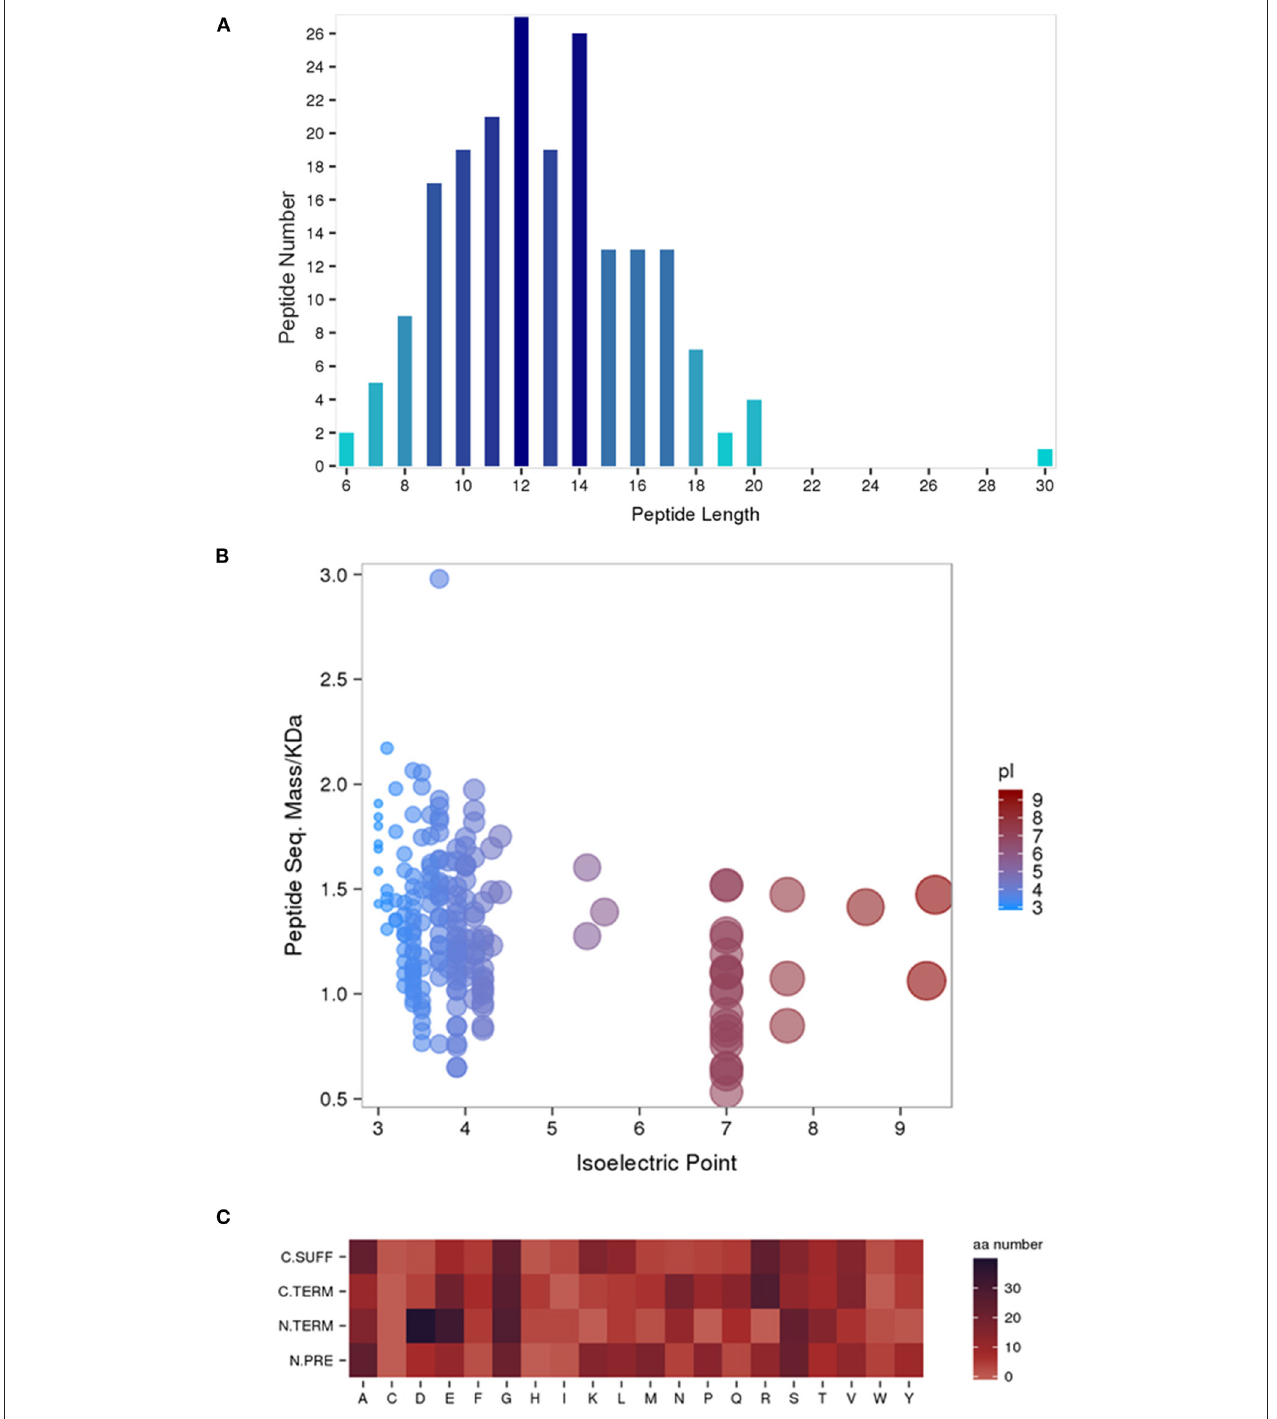
FIGURE 1 | General properties of the identified serum peptides by iTRAQ. Peptide lengths (A) . The molecular weight (Mw) vs. isoelectric point (PI) distribution of the identified total peptide segments (B) . Heat map of the amino acid distribution of the cleavage sites of the precursor proteins (C) . N. PRE represents the former amino acid at the N-terminus of the peptide, N. TERM represents the amino acid at the N-terminus of the peptide, (C) TERM represents the amino acid at the C-terminus of the peptide, and C. SUFF represents the latter amino acid at the C-terminus of the peptide.